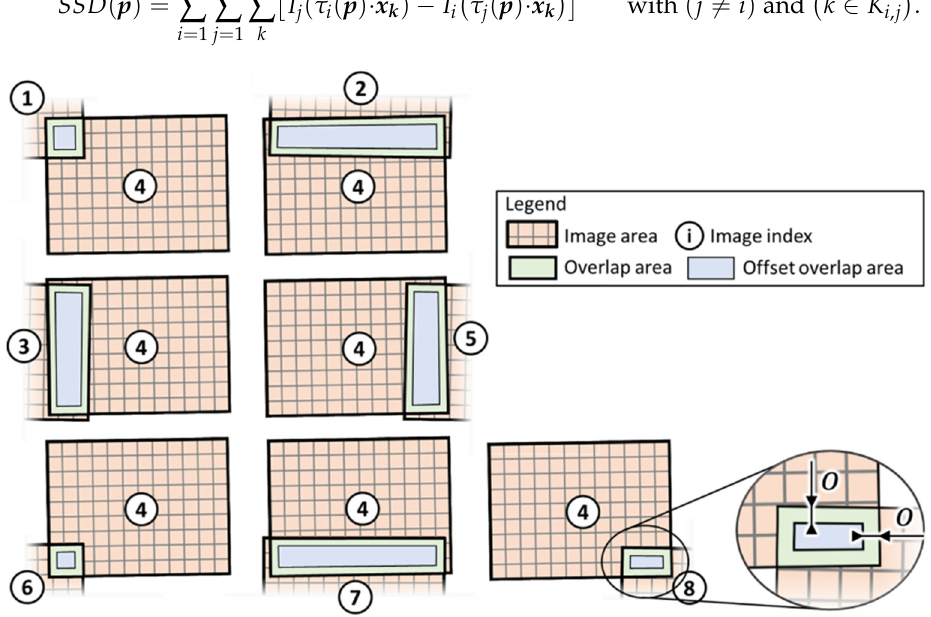
Figure 3. Illustration of all overlap areas between image #4 and neighbour images. The magnified region serves to clarify the relationship between the overlap areas and the offset overlap